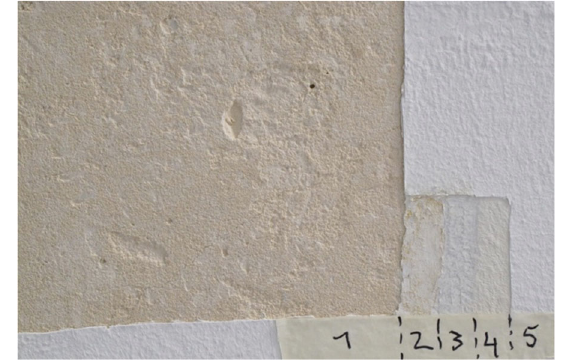
Fig. 15 Le Corbusier, Paris, Maisons La Roche-Jeanneret (double-house), Square du Docteur-Blanche in Paris (1923), 2008 – 2009 Restoration campaign led by architect Pierre-Antoine Gatier, probe: Ariel Bertrand. The main facade consists of a smoothed natural plaster of yellowish limestone, lime and white cement (?); the surface of the plaster shows that the surface is darker than the mortar matrix, probably due to sulfatation and sintering (Source: Ariel Bertrand, Paris